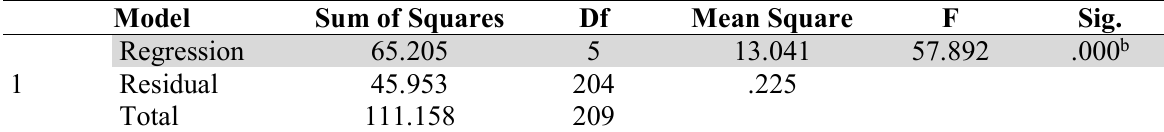
The results of ANOVA test